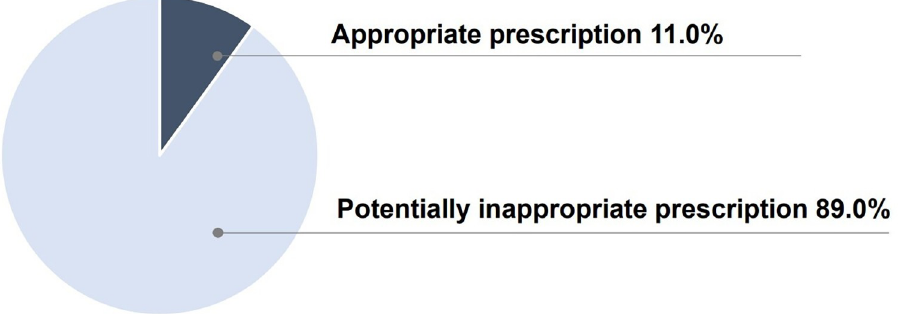
Fig 2. Classification of prescriptions based on